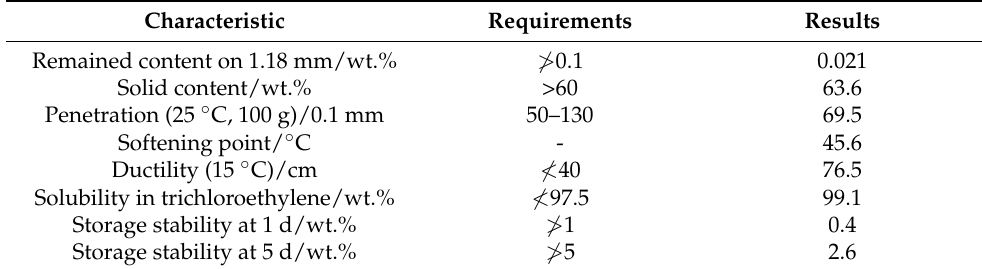
Table 2. Characteristics of coarse aggregate. Characteristic Requirements Results Crushed value/wt.%